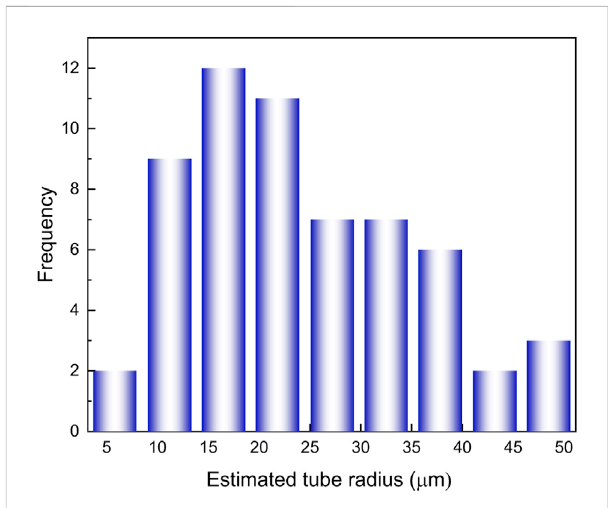
FIGURE 13 Histograms for the estimated tube radius for the fi ve-particle injection